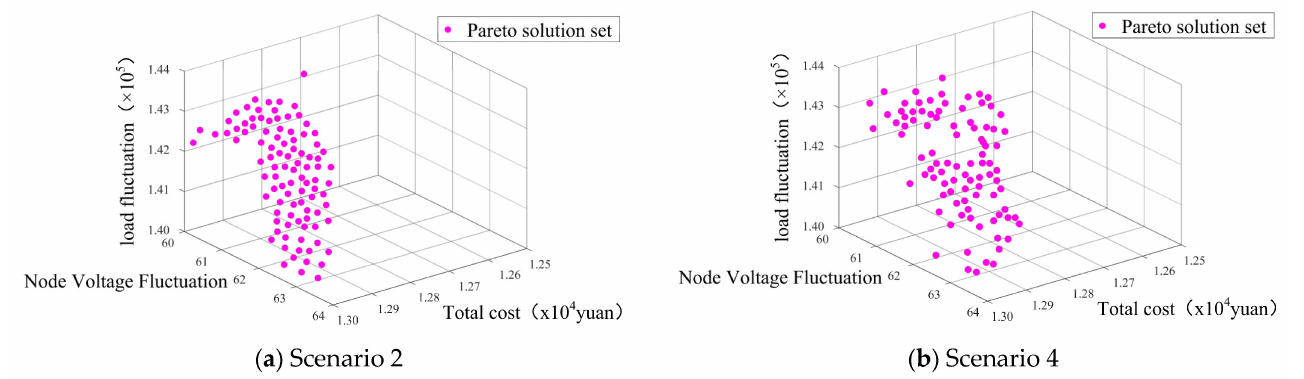
Figure 12. Pareto solution set